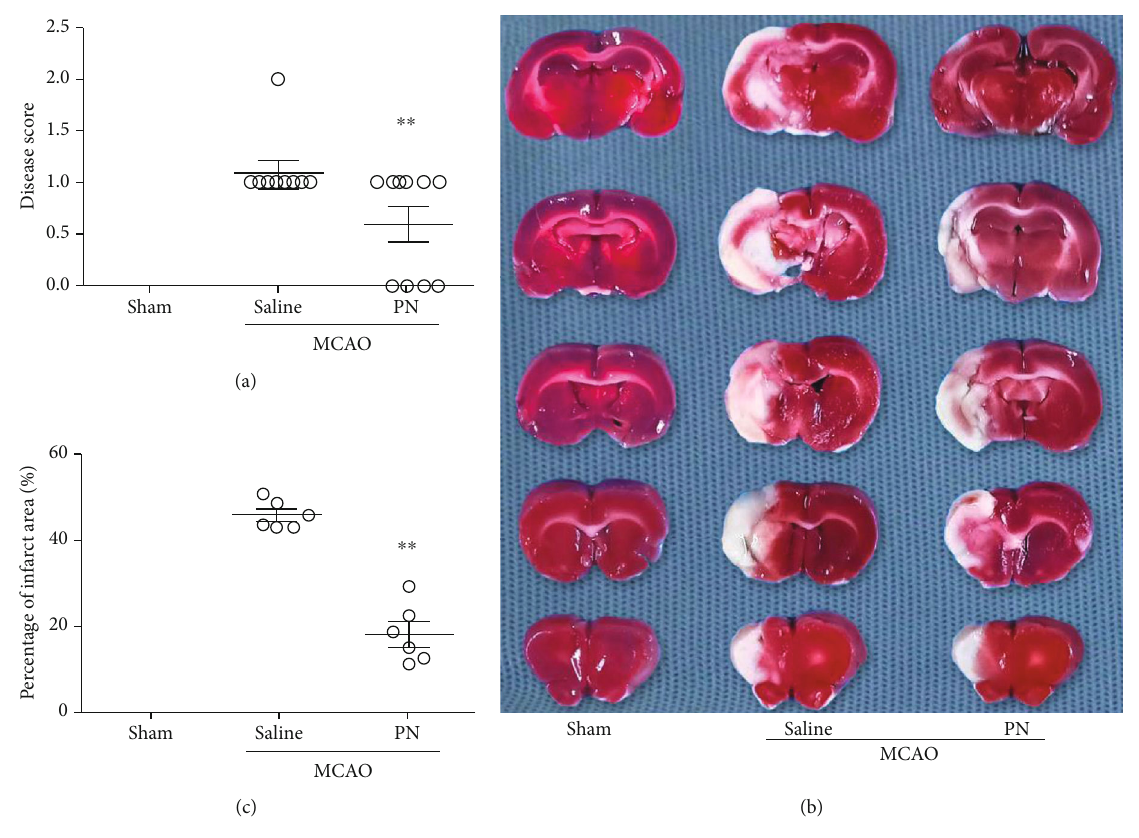
Figure 2: The e ff ects of PN on MACO in rat infarction volume. (a) Compared with the MCAO group treated with saline, scores of neural function were decreased in the PN group ( n = 10 in each group). (b) TTC staining, normal tissues are red and infarcted tissues are white. PN can e ff ectively reduce the range of cerebral infarction in rats. (c) Compared with MCAO group, the infarct area and percentage in the PN group decreased signi fi cantly ( n = 6 in each group). In (a) and (c), data shown indicated as mean ± SEM values. Similar experiments were performed at least 3 times. ∗ P < 0 : 05 ; ∗∗ P < 0 : 01 ; ∗∗∗ P < 0 : 001 .